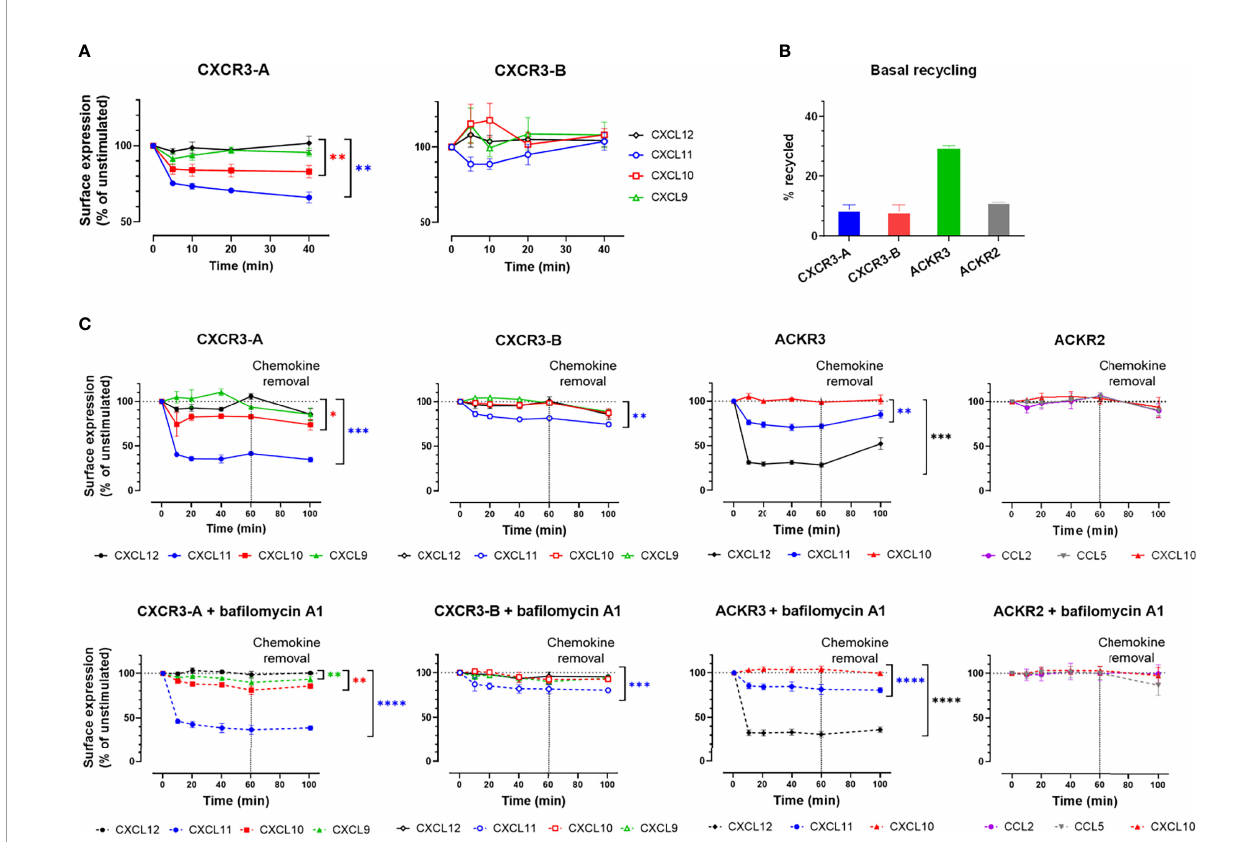
FIGURE 3 | CXCR3-B is mobilized to the cell membrane upon chemokine stimulation but does not cycle in basal conditions. (A, C) Cell surface redistribution of CXCR3-A and CXCR3-B after stimulation with chemokines (100 nM) monitored by (A) surface nanoluciferase complementation (HiBiT) or (C) fl ow cytometry in the presence or absence of ba fi lomycin A1. All assays were conducted in HEK293T cells. Results are expressed as percentage of receptor surface expression in basal conditions (100%) and represent mean ± SEM of three independent experiments. *p < 0.05, **p < 0.01, ***p < 0.001 and ****p < 0.0001 by repeated measures one- way ANOVA with Bonferroni correction. (B) CXCR3-A, CXCR3-B, ACKR3 and ACKR2 basal cycling after extracellular epitope shaving by proteinase K. Results are expressed as percentage of cell surface expression after proteinase K